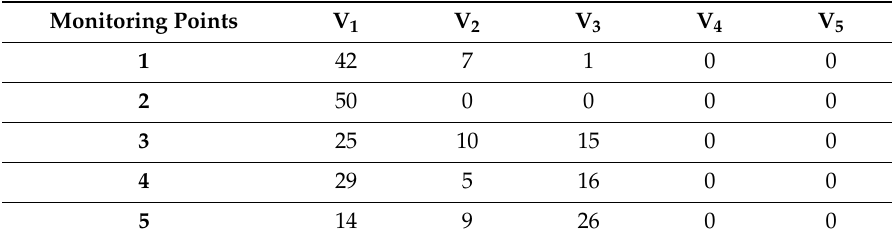
Table 3. The statistical number of the five evaluation indexes at the first period. Monitoring Points